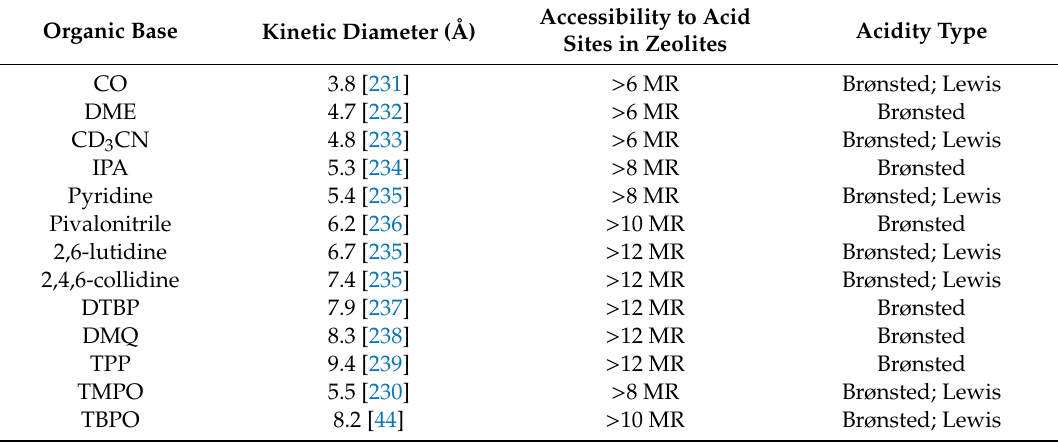
Table 10. Representative organic base molecules used in acidity determination in 2D zeolites. Organic